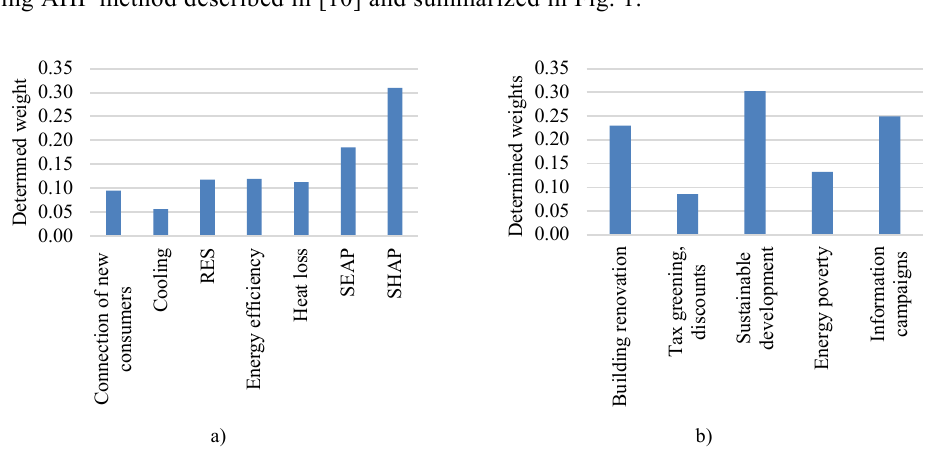
Fig. 1. Determined weights of direct aspects for a) local planning documents and b) indirect aspects for all planning documents. In order to determine the impact of the weights of the criteria set by the AHP on the evaluation of criterion, a re-evaluation of criteria is performed, assigning equal values to all